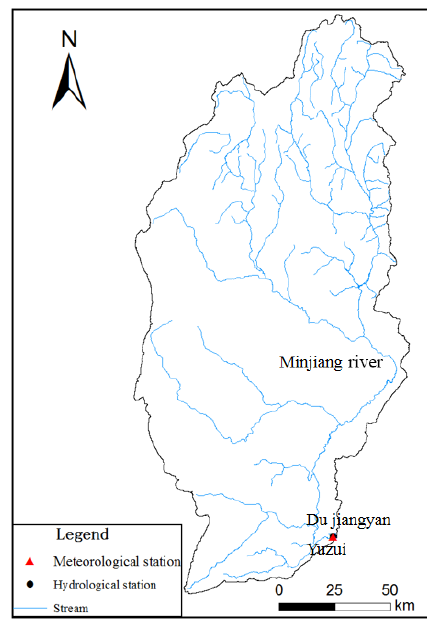
Figure 1. Location of study area and hydrometeorological